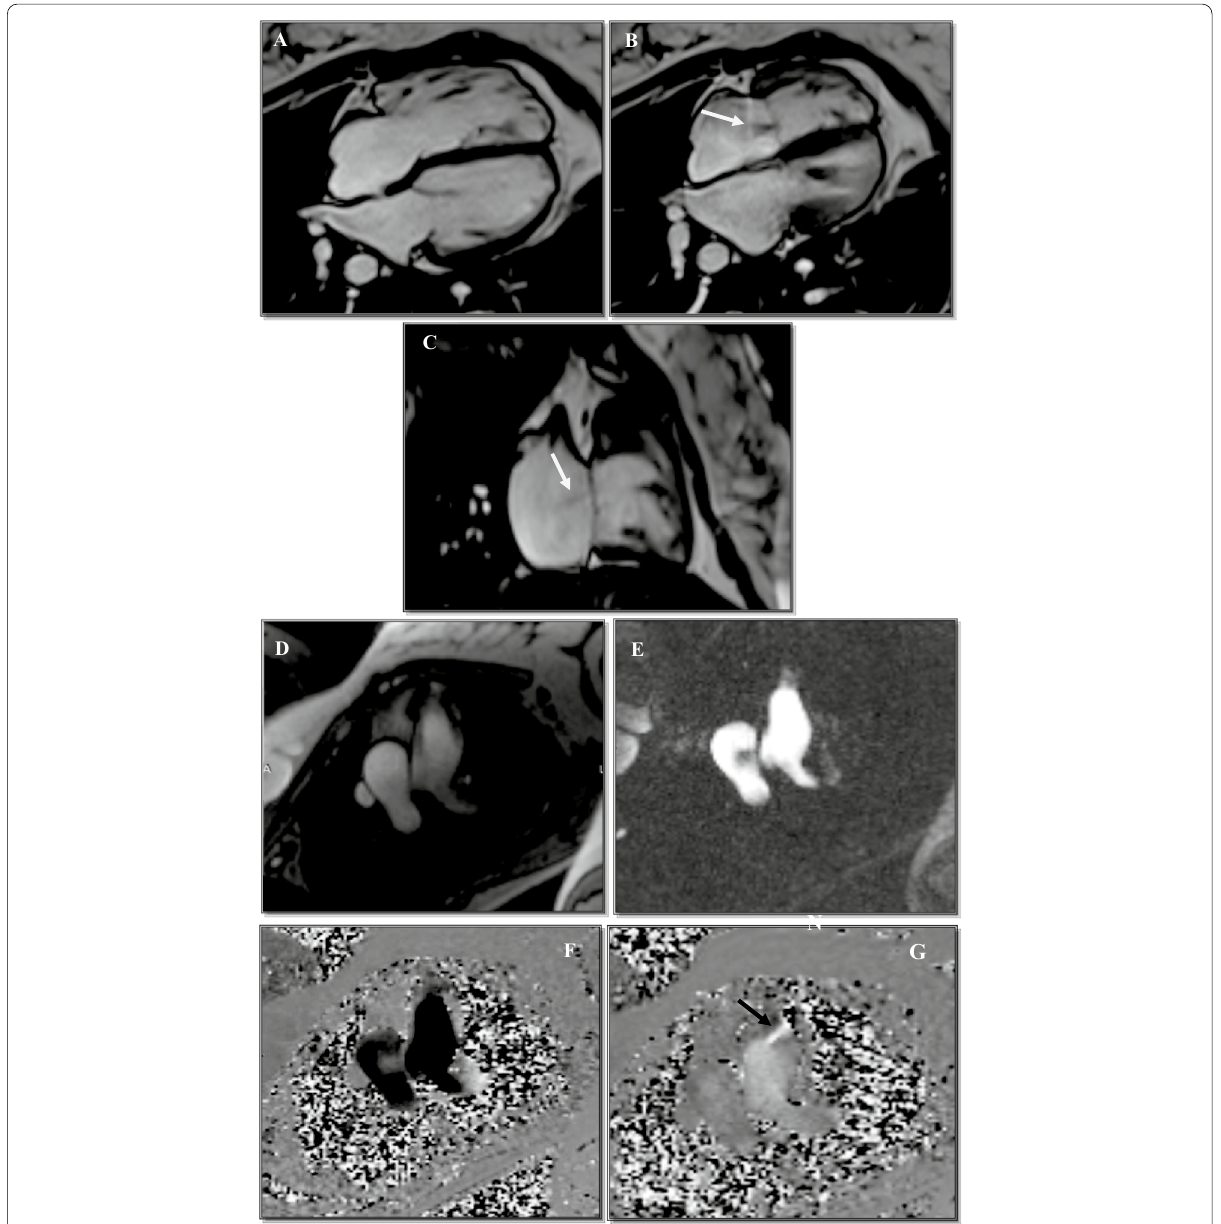
Fig. 2 A – O CMR revealed: Dilated non-hypertrophied RV, moderate PR, RF 45%, no PS, moderate TR, RF 32%, mild AR, RF 17%, enhancement = = = related to TAP and VSD patch. A 23-year-old female patient, diagnosed as tetralogy of Fallot, underwent trans-annular patch repair at age of 1 year. The patient was referred for baseline CMR study for 1st follow-up. A 4-chamber cine images at diastole, B at systole and C right 2-chamber cine image at systole showing dilated, non-hypertrophied right ventricle at end-diastolic phase and dephasing jet of tricuspid regurgitation during ventricular systole as well. D , E , F Coronal pulmonary phase-contrast velocity encoding sequence (in-plane, Venc 1.5 m/s); anatomy, magnitude and phase images showing no aliasing across denoting no residual stenosis. G Coronal pulmonary phase-contrast velocity encoding sequence (in-plane pulmonary with Venc 1.5 m/s); phase image showing dephasing regurgitant pulmonary jet. H Phase-contrast velocity encoding sequence at sub-pulmonic level (through-plane, Venc 1.5 m/s); phase image for better assessment of the backward blood volume and consequently better assessment of the regurgitant fraction as well. I, J 3-chamber left cine image at diastole and LVOT cine image at diastole showing dephasing jet of aortic regurgitation, regurgitant fraction calculated from the phase-contrast velocity encoding sequence (through-plane at aortic valve), RF 17%. = K , L , M Phase-contrast velocity encoding sequence at sub-aortic level (through-plane, Venc 1.5 m/s); anatomy, magnitude and phase images for better assessment of the backward blood volume and consequently better assessment of the regurgitant fraction as well. N , O Short axis and 3-chamber late gadolinium enhancement sequences (LGE) showing enhancement at the site of TAP and VSD